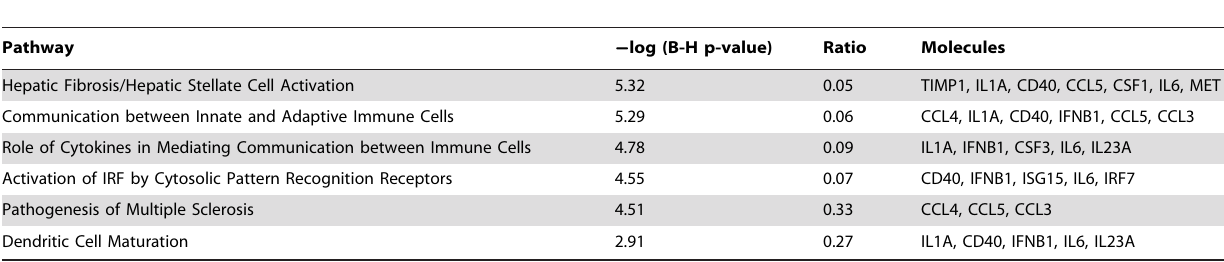
Table 2. Canonical pathways over represented in the genes that are upregulated in the core set of differentially expressed genes.